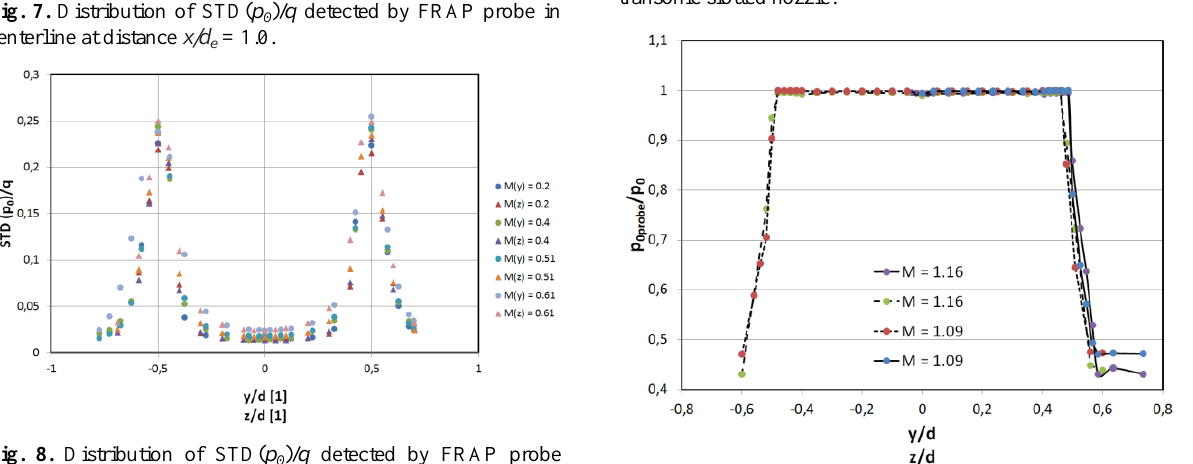
Fig. 8. Distribution of STD( p 0 )/ q detected by FRAP probe across of the free stream at distance x/d e = 1.0.